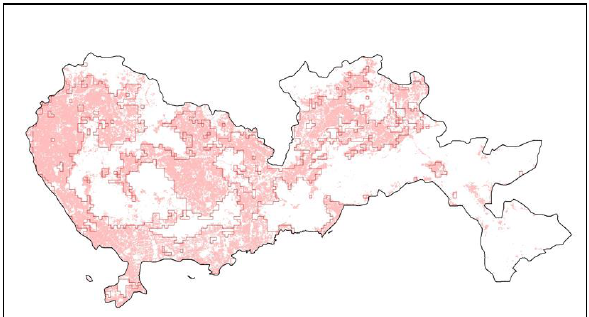
Figure 9. SNPP-VIIRS (Shenzhen)